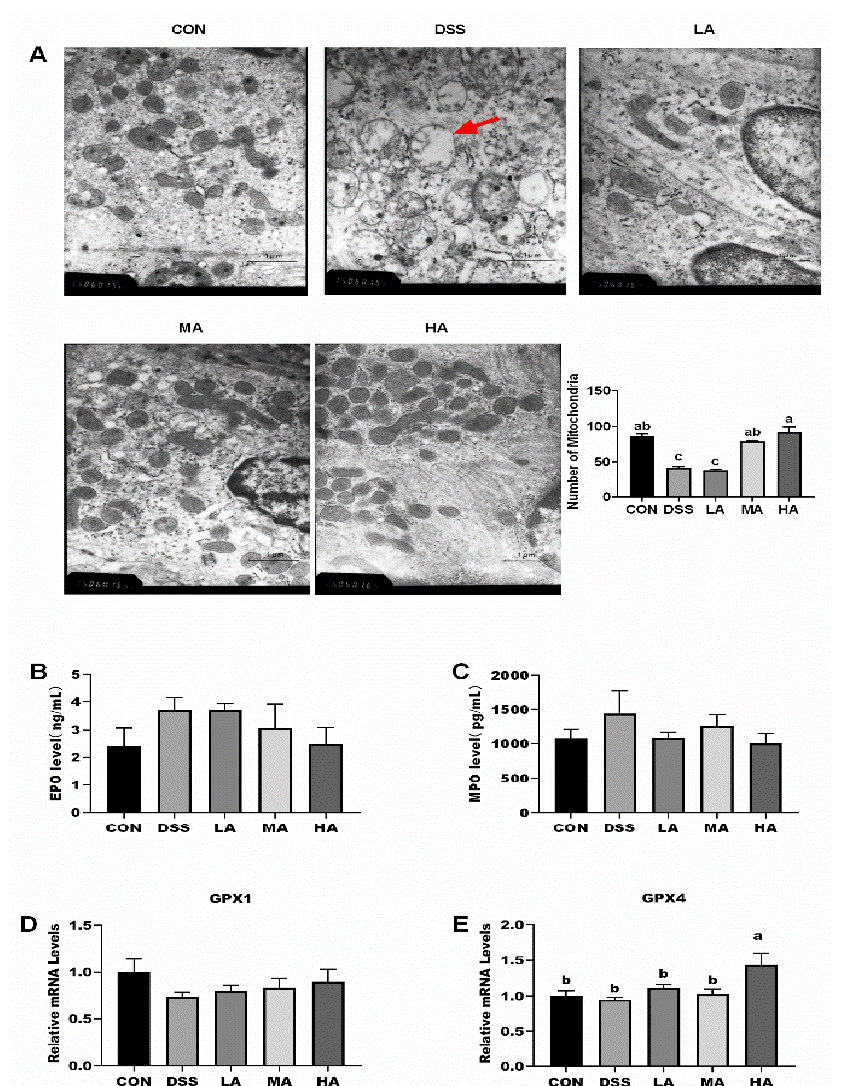
Figure 3. The effects of aspartate on intestinal mitochondria ultrastructure and antioxidant indices in the colon of the DSS-induced mice. ( A ) The morphology and number of colonic mitochondria, black oval mitochondria. ( B ) The content of MPO. ( C ) The content of EPO. ( D ) The mRNA expression level of colonic GPX1. ( E ) The mRNA expression level of colonic GPX4. Values are expressed as the mean ± SEM, n = 6. a, b, c Mean values with different small letter superscripts mean a significant difference ( p <